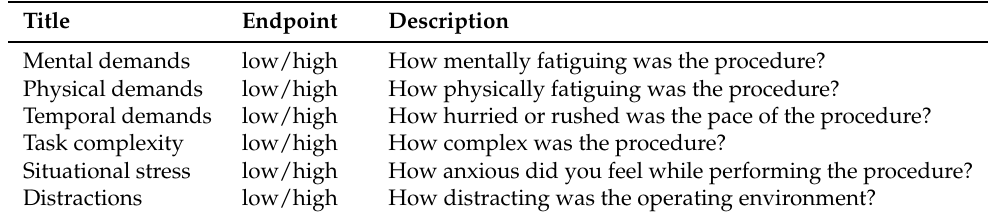
Table 2. SURG-TLX mental workload self-rating questionnaire